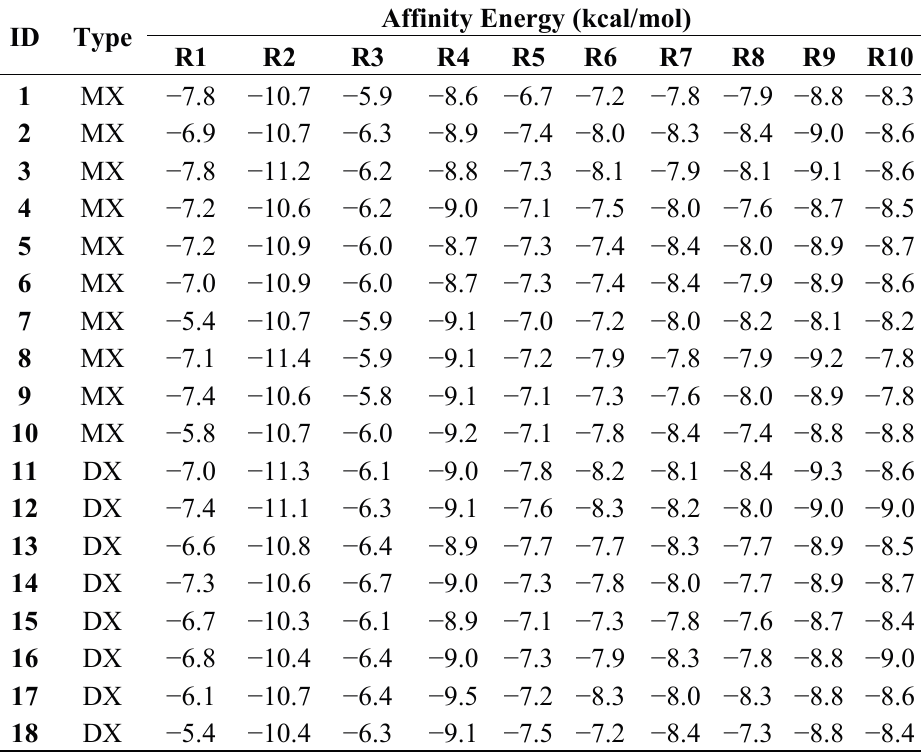
Table 2. Affinity energies a from docking of xanthones with target